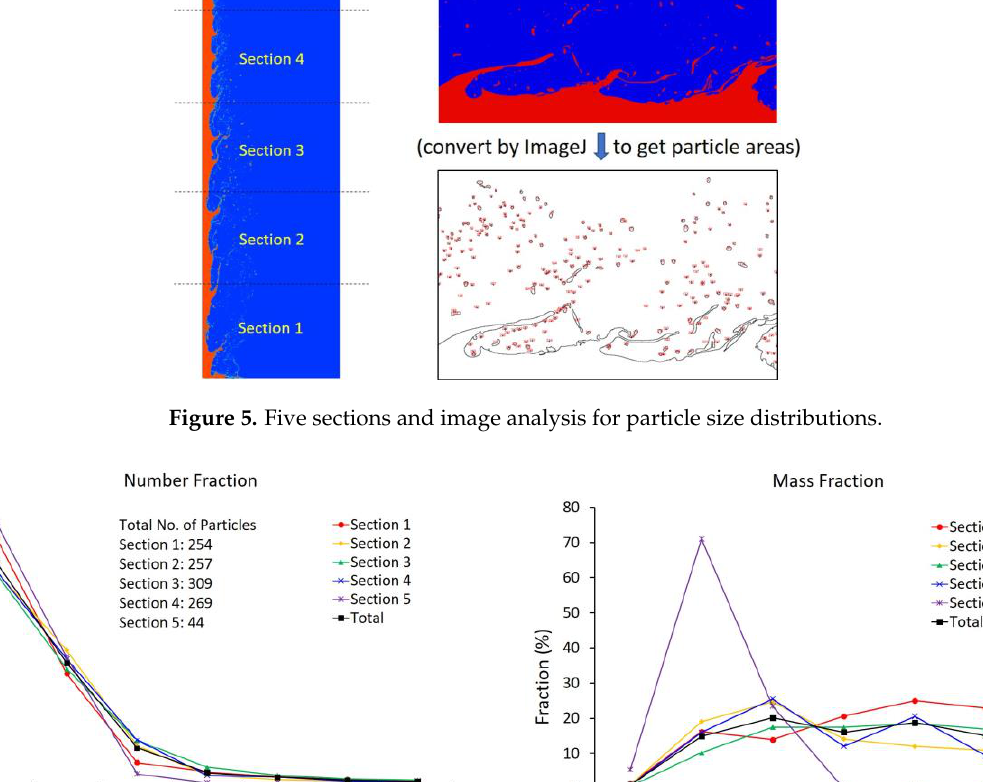
Figure 6. Particle size distribution by number of particles ( left ) and by mass ( right ).